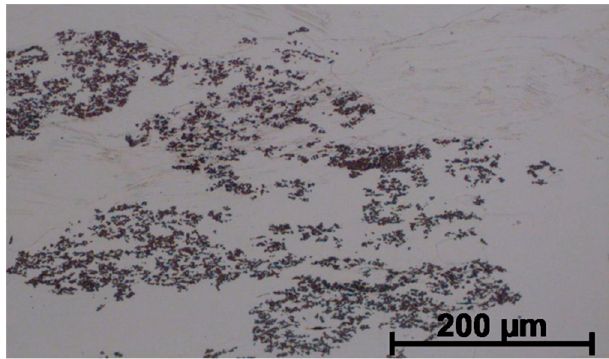
Figure 7. Structure of Cu–2Ni–1Si–0.6Re alloy: supersaturation 950 °C; time 1 h, water cooling (Ar); plastic deformation 50%; ageing 450 °C 1 h.